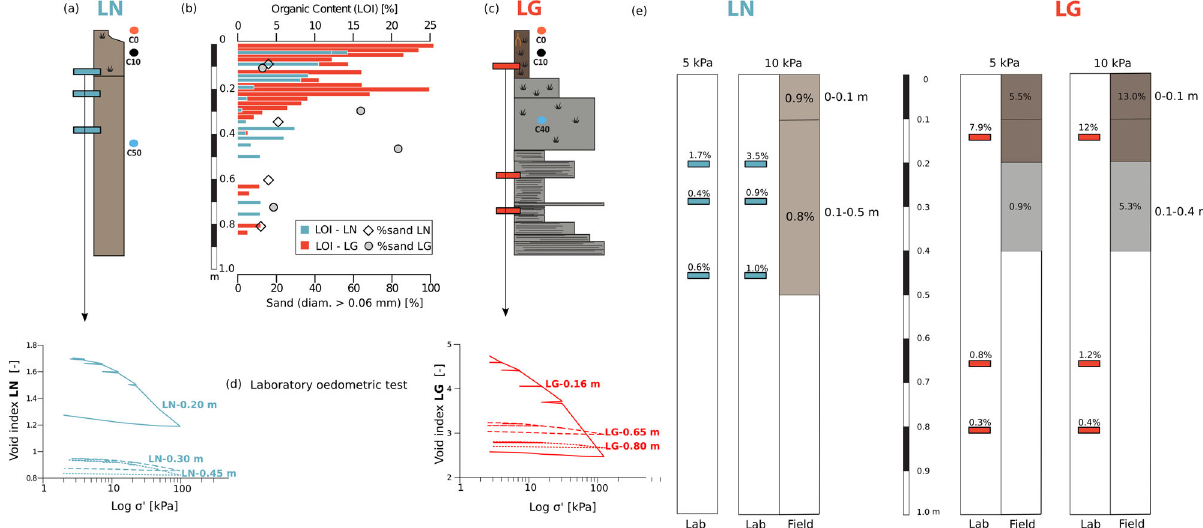
Fig. 4 Comparison between fi eld measurements and geotechnical laboratory test results for Lazzaretto Nuovo (LN) and La Grisa (LG). a , c Position of the displacement transducers and oedometer samples in the 1-m stratigraphic pro fi les of Fig. 2e, f. b Organic content obtained through LOI tests and sand percentage derived from the granulometric curves (Supplementary Fig. 4a). The sand percentage allows us to easily recognize the stiff layer between 0.3 and 0.5 m where the C40 sensor was positioned at LG. d Results of the classical oedometric tests (void index versus effective stress). Undisturbed samples were collected at 0.2, 0.3 and 0.45 m at LN (Fig. 4a) and 0.16, 0.65 and 0.8 m at LG (Fig. 4c). e Comparison of fi eld and lab deformations at ∼ 5 and ∼ 10 kPa. Field data provide an average value over the depth intervals between 0.0 and 0.1 m depth and from 0.1 to 0.5 m (0.4 m at LG) depth, while lab data provides point estimates at the respective sample